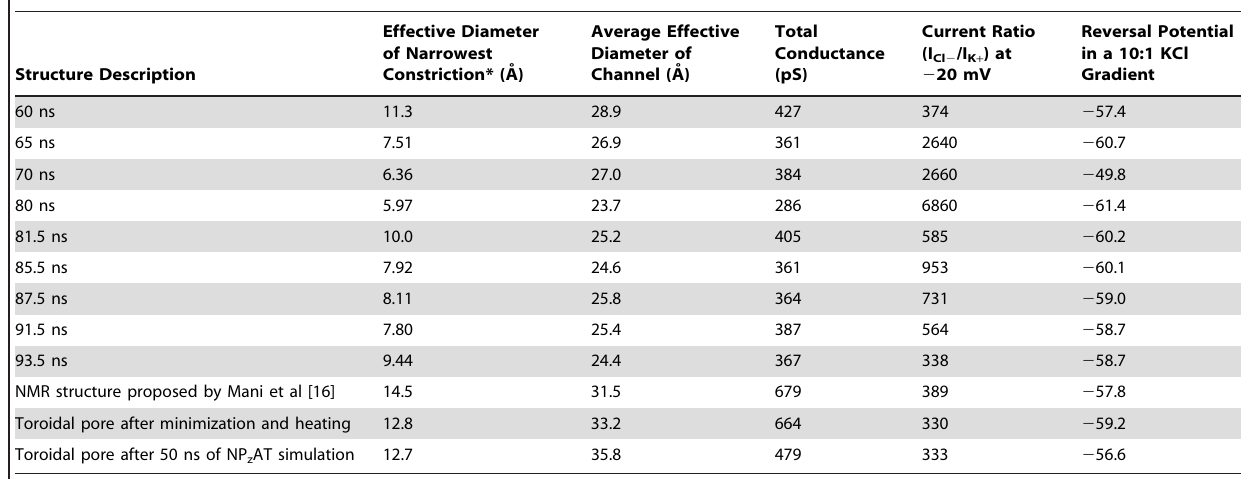
Table 1. Conductance characteristics measured for a variety of structures.